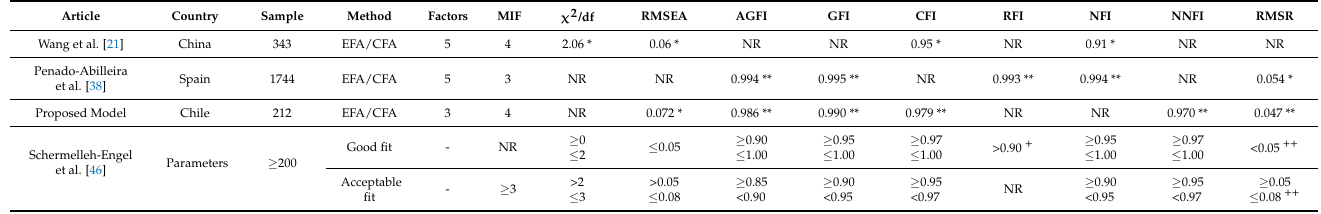
Table 8 sets out the proposed model results in comparison with the resulting validity and reliability values in Wang et al. [21] and Penado-Abilleira et al. [38], for the RMSEA, AGFI, GFI, CFI and RMSR indicators by FACTOR software. In comparative terms, the proposed model reports an RMSEA with an acceptable fit equal to Wang et al. [21], AGFI and GFI with a good fit equal to Penado-Abilleira et al. [38], CFI with a good fit in contrast to the acceptable fit reported by Wang et al. [21], and RMSR with a good fit in contrast to the acceptable fit reported by Penado-Abilleira et al. [38]. Table 8. Validation and reliability reported in previous articles and